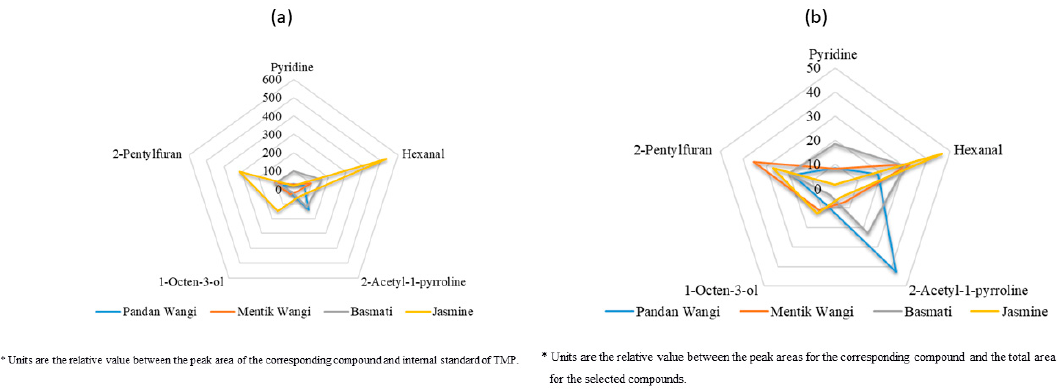
Figure 2. The relative levels of key-marker volatile compounds in tested rice grain samples ( a ) and the proportion of the compounds contributing to the total aroma compounds ( b ).